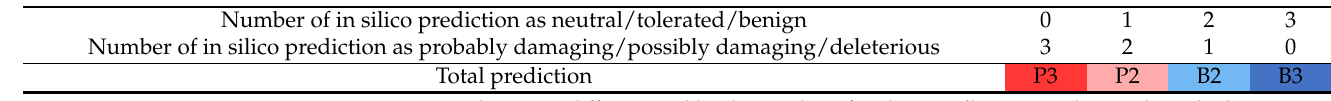
Table 4. Prediction methods for Figure